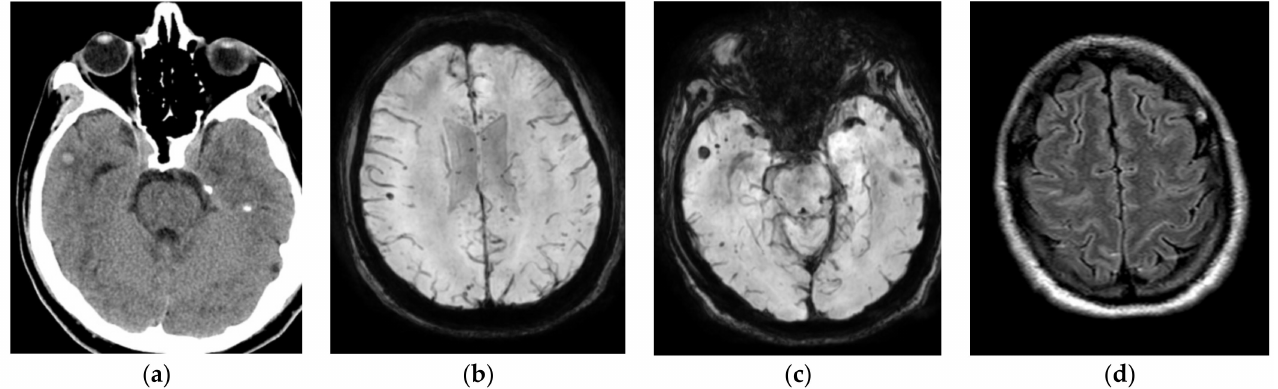
Figure 2. Multiple hemorrhages in the supratentorium. CTH without contrast showing right temporal hyperdensity suggestive of hemorrhage ( a ). MRI of the brain with and without showed small right anterior temporal lobe intraparenchymal hemorrhage ( b ); additional multiple scattered foci of susceptibility artifact particularly in the gray–white junctions and corpus callosum ( c ); and sulcal FLAIR hyperintensity in the right frontal, biparietal, and left temporal lobes ( d